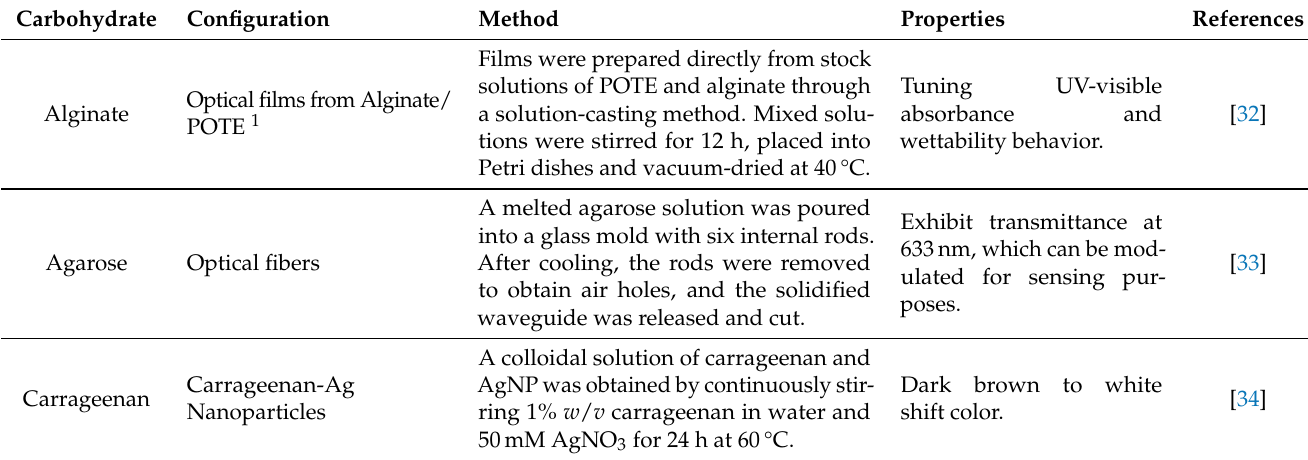
Table 1. Carbohydrate based structured material and their optical